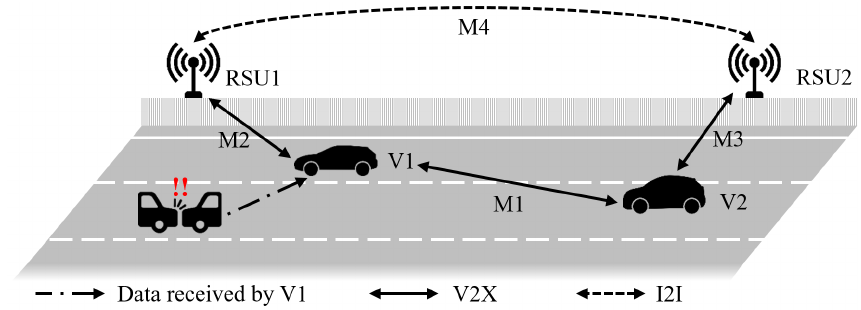
Figure 5. Cloud formation scenario for validating the proposed semantic model.